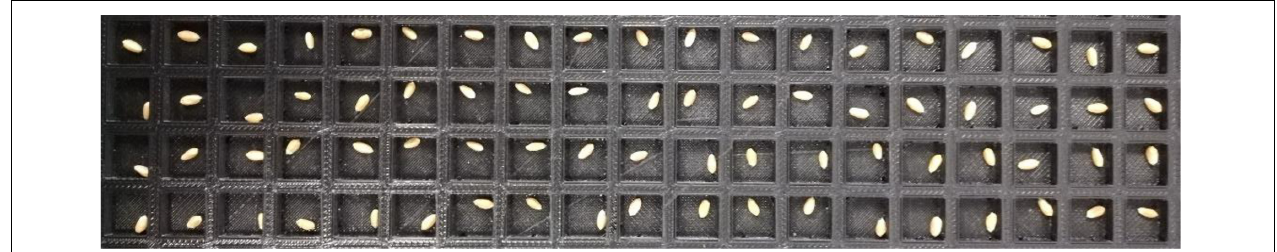
FIGURE 1 | A batch of wheat kernels.